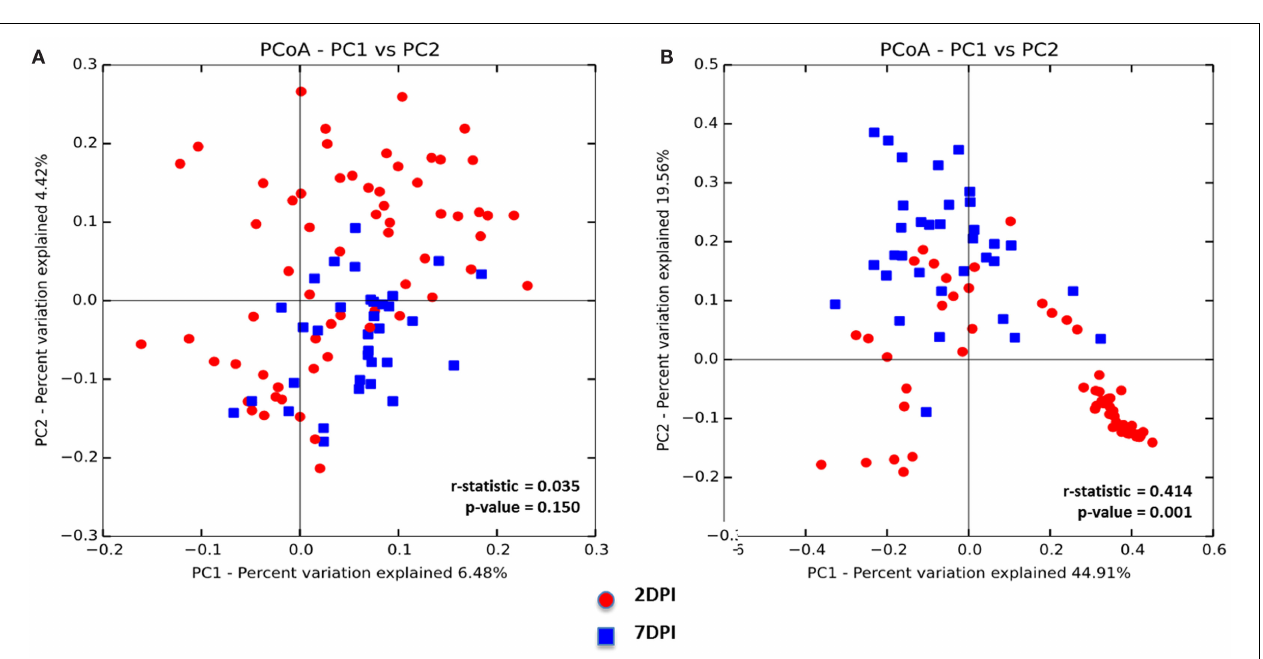
FIGURE 5 | Principal coordinate analysis (PCoA) based on (A) unweighted and (B) weighted UniFrac distances was analyzed for two age groups of infected chicks . ANOISM with 999 permutations was used to detect the statistical significant difference between microbial communities of different groups, where both r and p value is reported. Abbreviations: 2DPI, 2days post infection; 7DPI, 7days post infection.